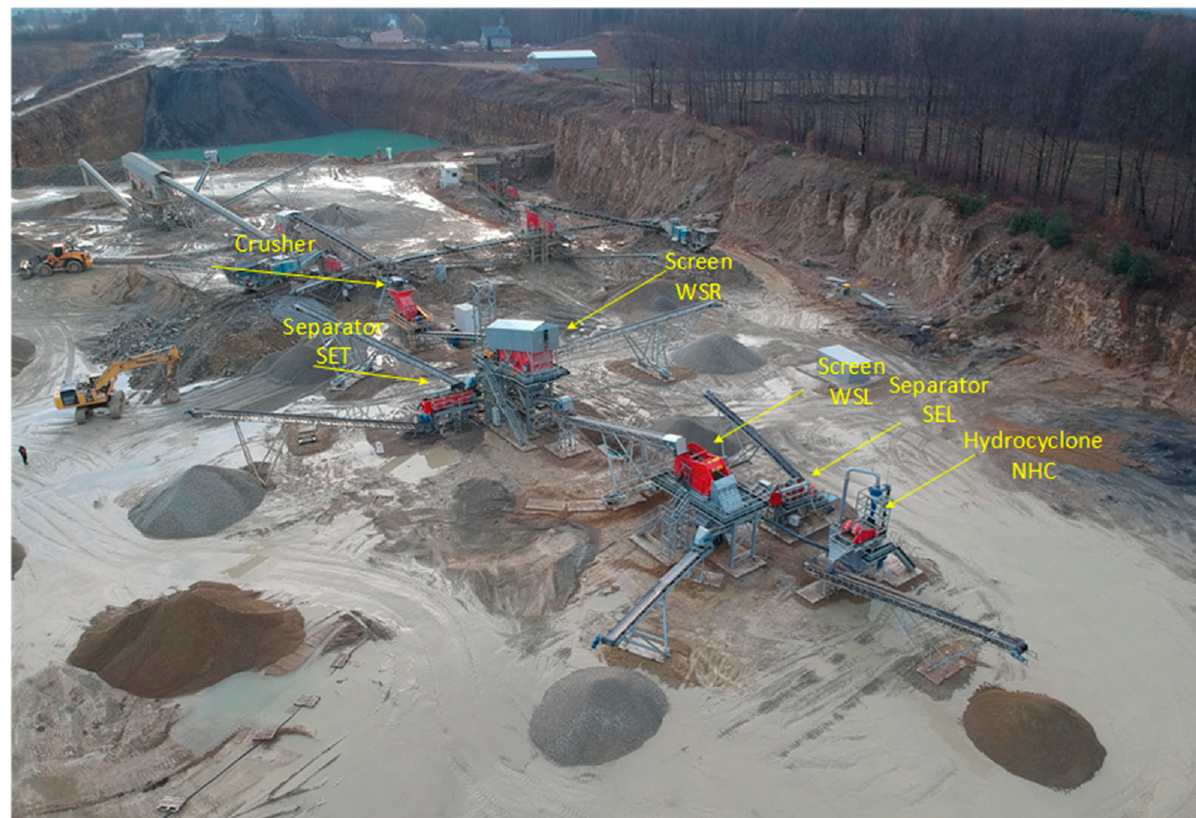
Figure 1. Technological line in the Imielin Dolomite Mine, image from a drone. The process line includes: I.